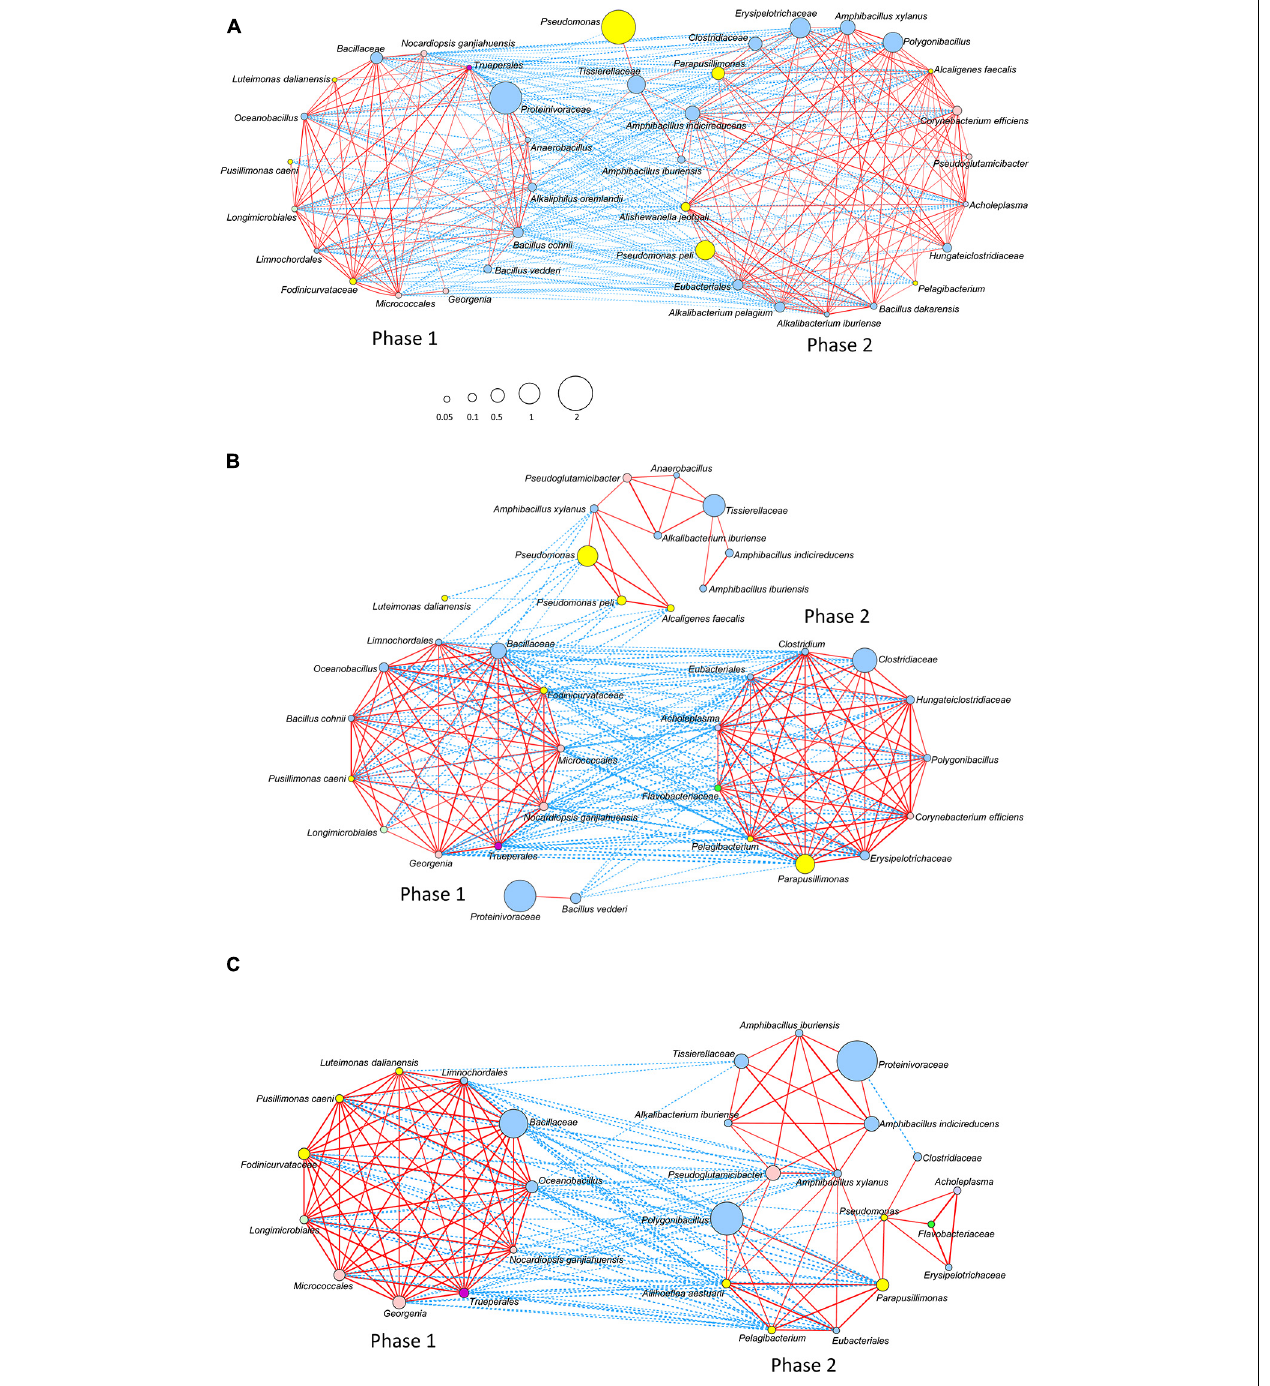
FIGURE 5 | Networks of the bacterial community based on the relative content change trend analyzed with Spearman’s rank correlation coefficient [ rs > 0.4, p < 0.05; (A) ] Batch 1; (B) Batch 2; and (C) Batch 3. The red and blue lines represent positive and negative correlations, respectively. The thickness of the lines shows the strength of the relationship (0.4 < rs ≤ 1). Node size shows accumulated taxon abundances during the entire fermentation period. Classification at the phylum level is as follows: pale blue, Firmicutes ; yellow, Proteobacteria ; flesh color, Actinobacteria ; bright green, Bacteroidetes ; pale green, Gemmatimonadetes ( Longimicrobiales ); dark purple, Deinococcus - Thermus ( Trueperales ); and light purple, Tenericutes ( Acholeplasma ). The relative abundance is shown by the size of circle.